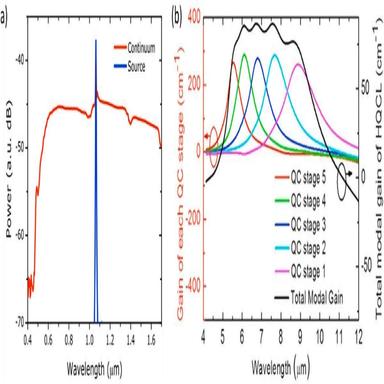
(a) Example spectrum of a supercontinuum laser. (b) Example Spectrum from a quantum cascade laser.